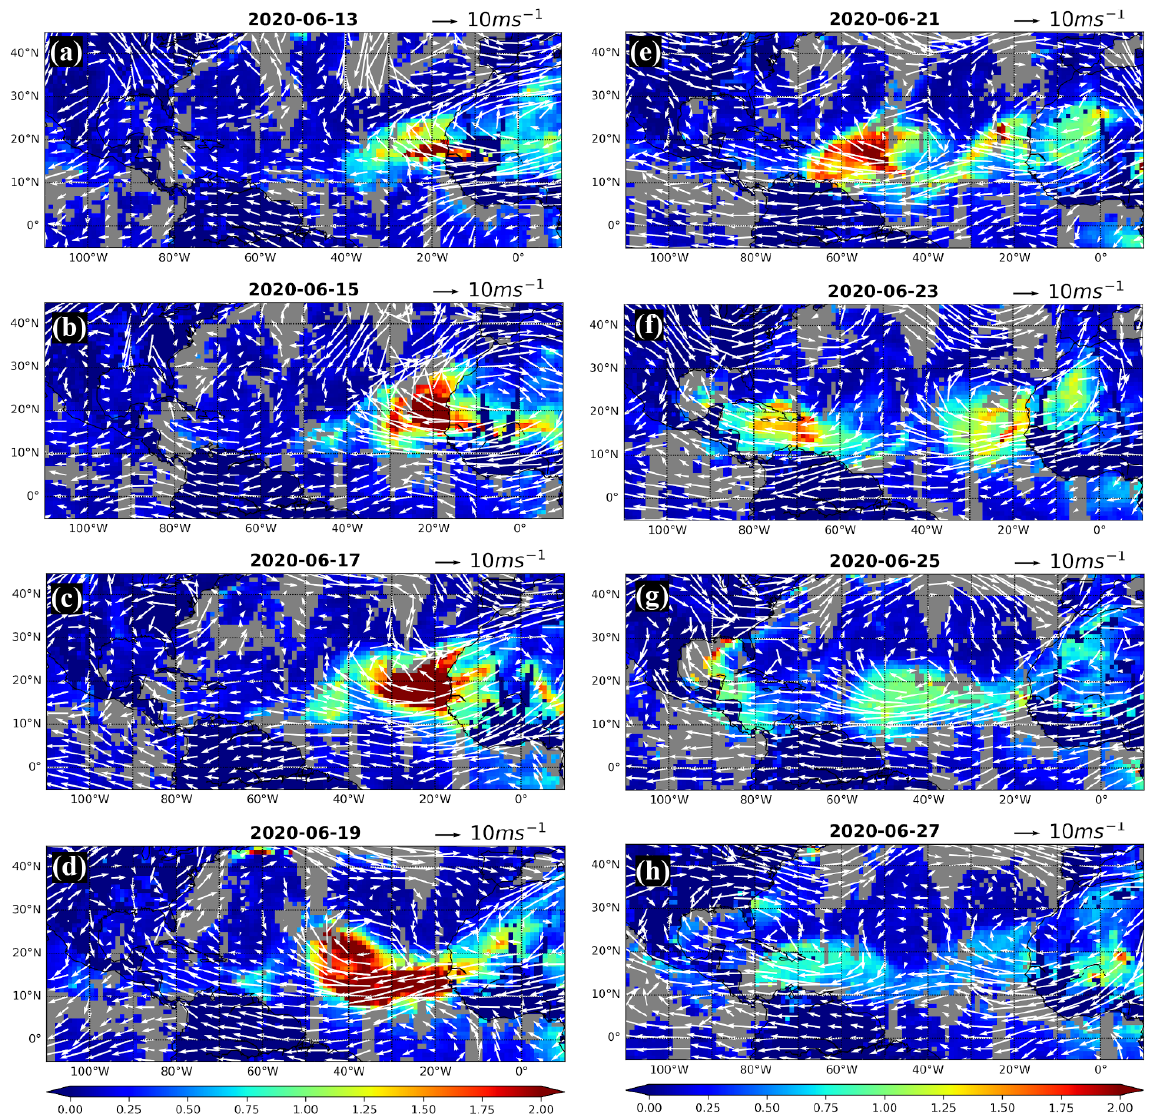
Figure 2. Evolution of dust plumes as revealed by MODIS AOD (color map) from 13 to 27 June 2020. Overlaid on the AOD is the MERRA-2 wind vectors at about 4km altitude, which illustrates how the dust plumes are carried by atmospheric circulations from the coast of North Africa to the Caribbean Basin and the southern US. Gray areas indicate MODIS data gaps due to the presence of clouds or other unfavorable conditions for the